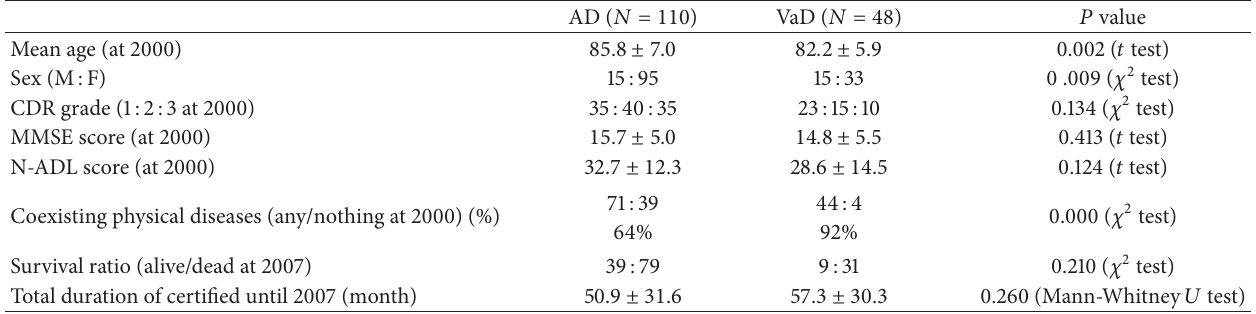
Table 2: Demographic variables of AD and VaD